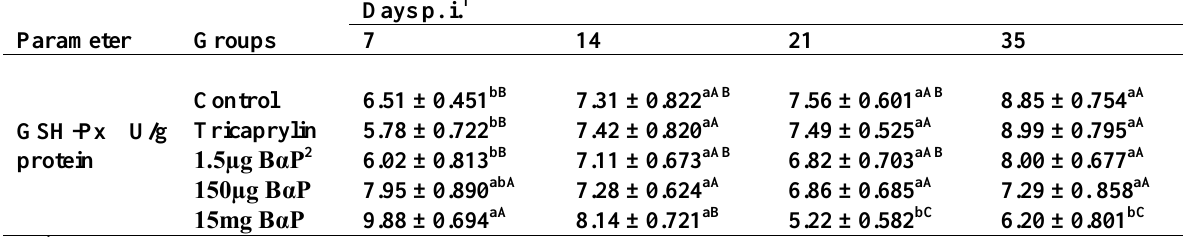
Table (2): Changes in glutathione peroxidase (GSH-Px) activity (U/g protein) in liver tissue homogenate (mean ± SD) of broiler males treated with BαP.